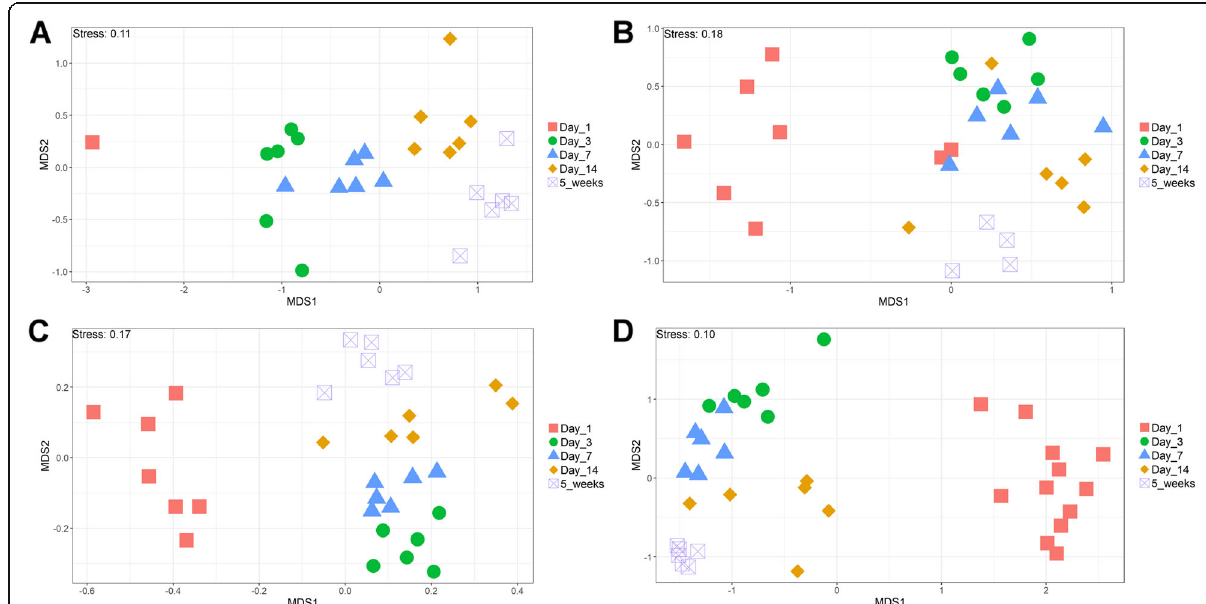
Fig. 2 NMDS comparing sample types across timepoints. NMDS of chicken intestinal content samples clustered by microbial community composition (Bray-Curtis dissimilarity). a : duodenum, b : jejunum, c : ileum and d :